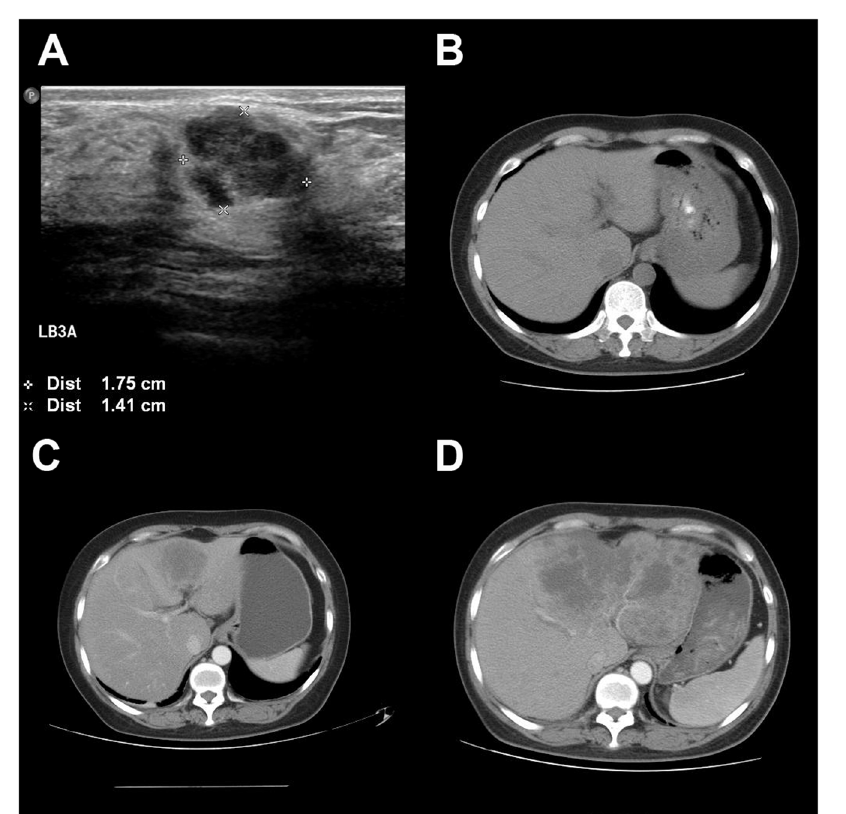
Figure 3. Representitive images of one patients with PR negative breast cancer. (A) Ultrasonography of the primary breast tumor before surgery (Dec, 2009). (B) No metastatic lesion showed on abdominal CT scan before surgery(Dec, 2009). (C) Liver metastasis confirmed by core needle biopsy 10 months after the surgery (Oct, 2010). (D) Last abdominal CT scan shortly before the patient died, which suggested no response to chemotherapy (Sept,